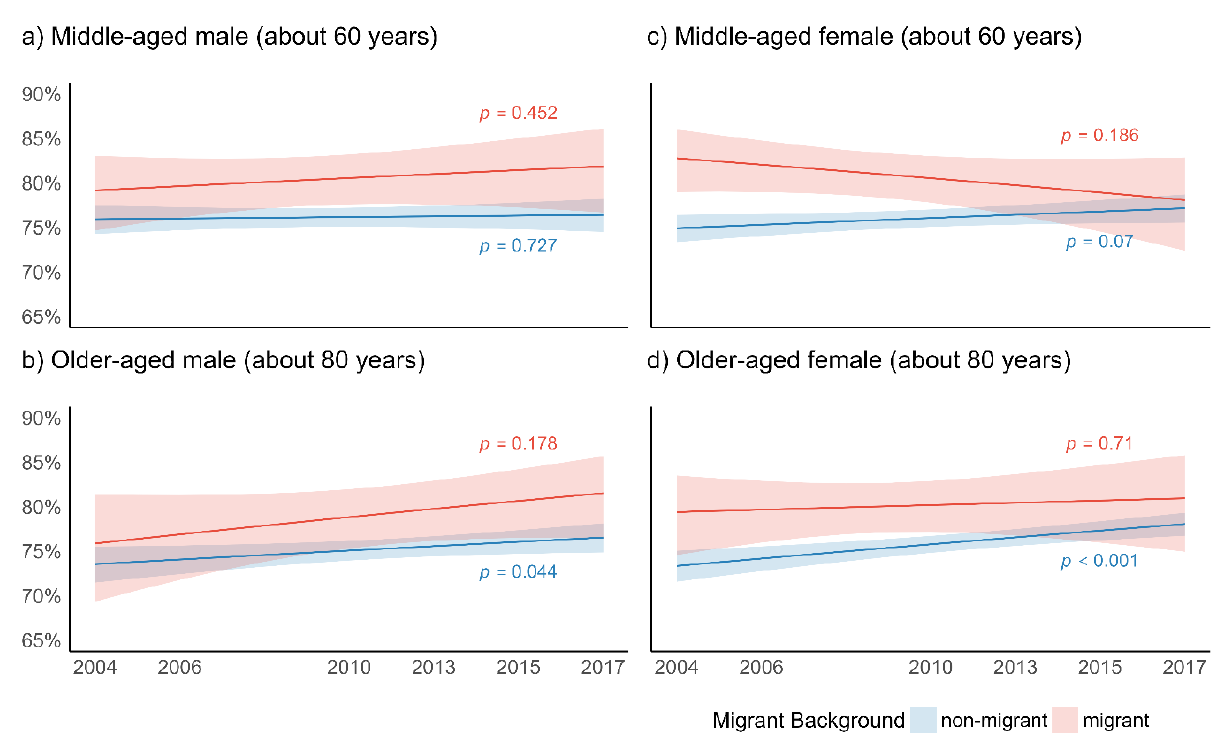
Figure 3. Predicted probabilities of self-rated health (% less than good health) for migrant background, age, and gender (across 6 waves of SHARE; model 3.2); p -values relate to change over time for migrant and non-migrant elderly.